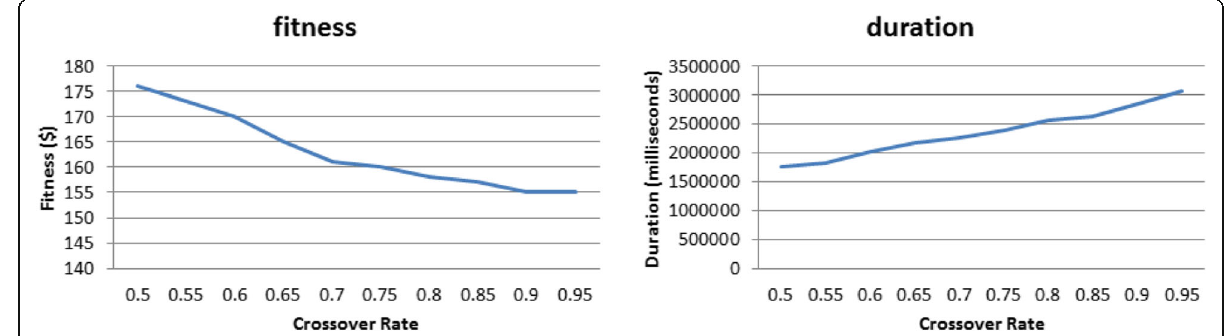
Fig. 7 The crossover rate ’ s effect on the fitness value and the experiment